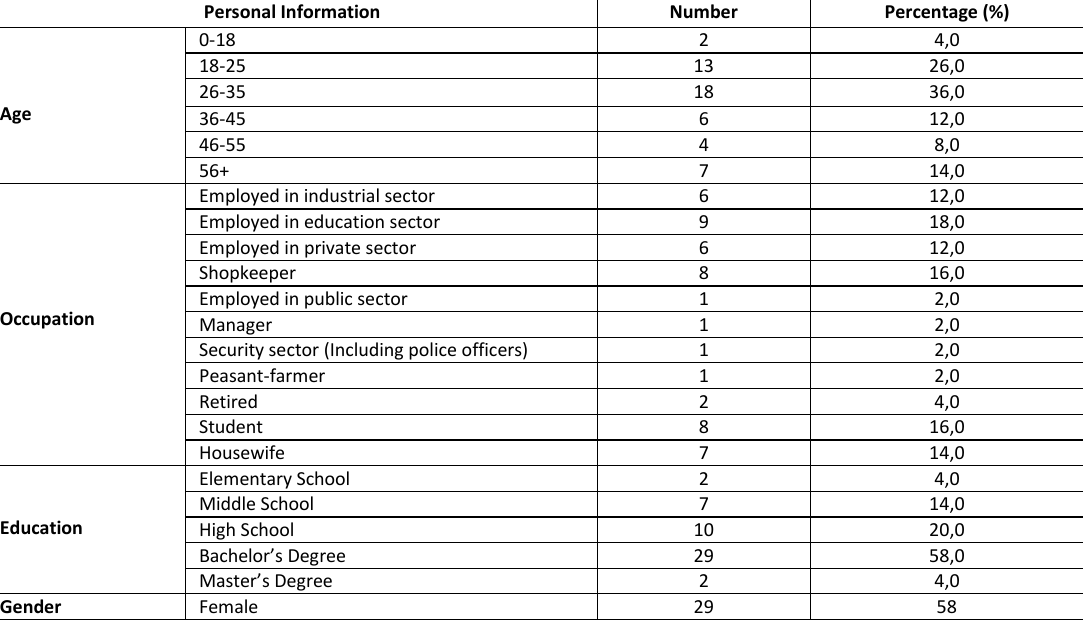
Table 2 User profiles of questionnaire application (Ünal,